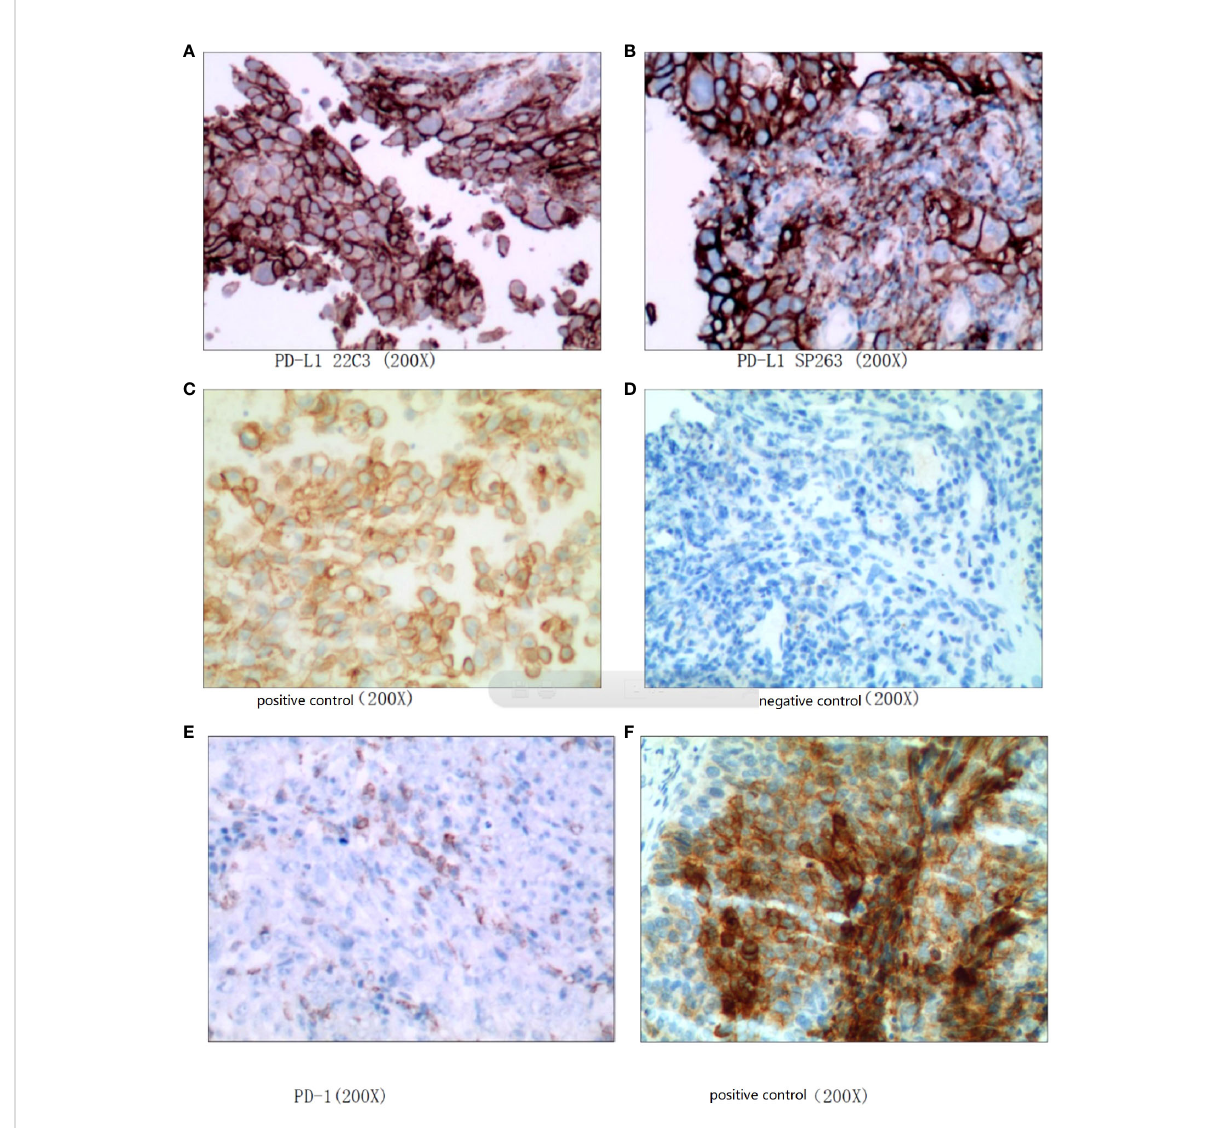
FIGURE 2 High-grade urothelial carcinoma. (A – D) : PD-L1 (CPS: 70), (E, F): PD-1 (positive tumor cell number